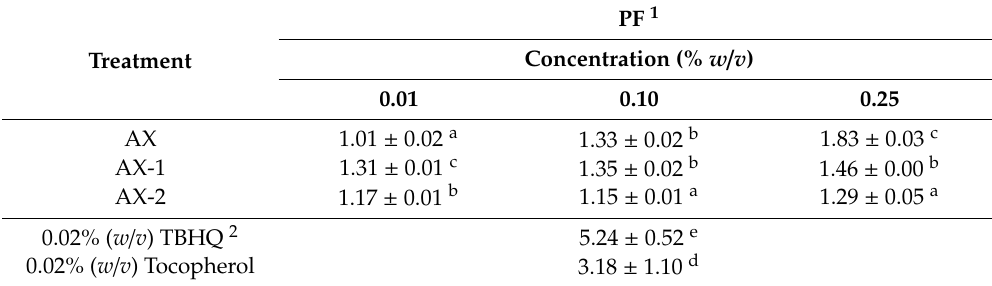
Table 3. Protection factor values of AX on oxidative stability of soybean